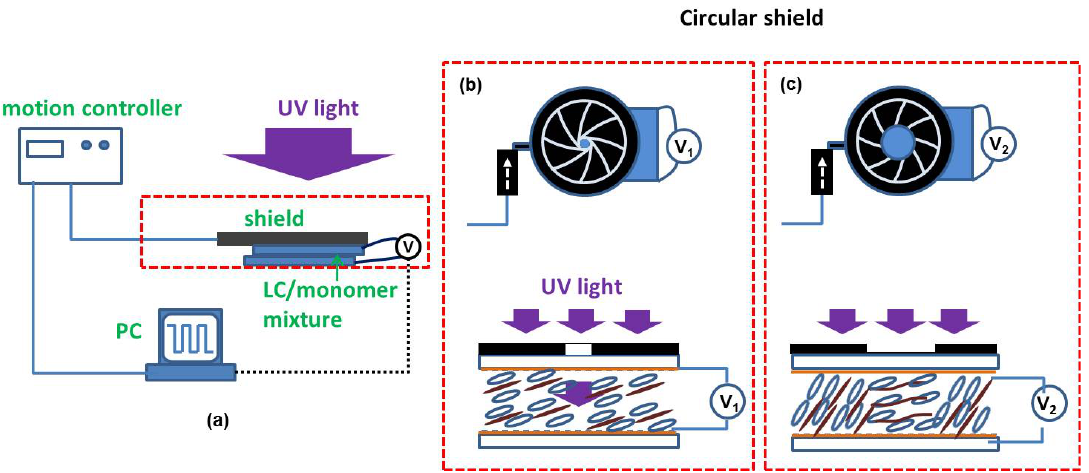
diaphragm and exposure for generating spatial gradient refractive index at V